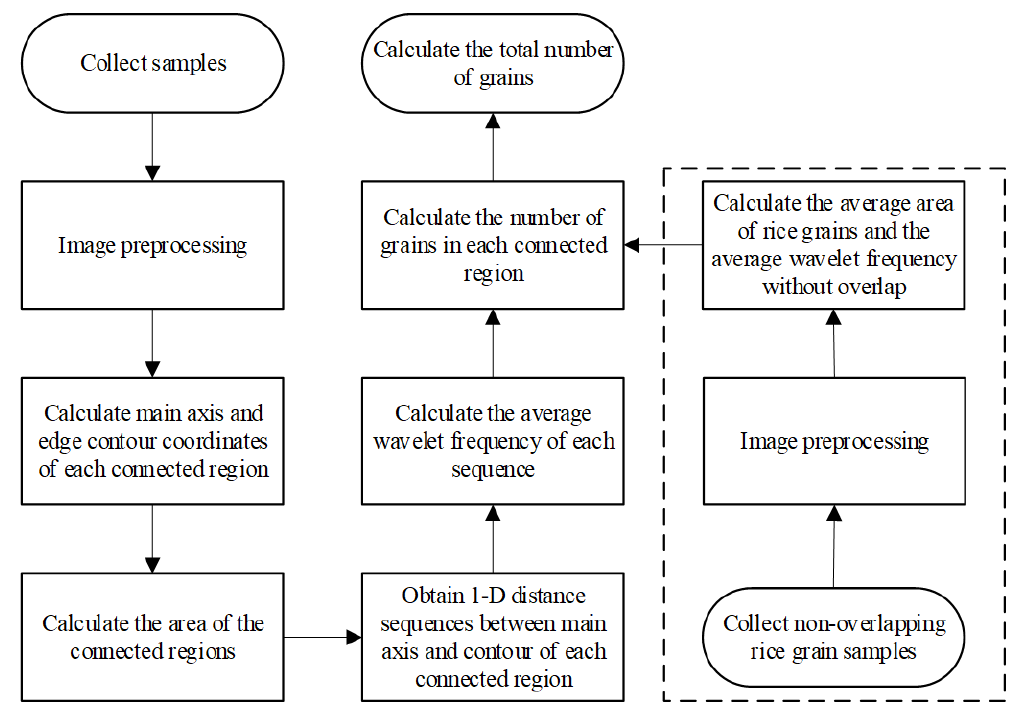
Figure 1. Flow chart of rice counting algorithm.